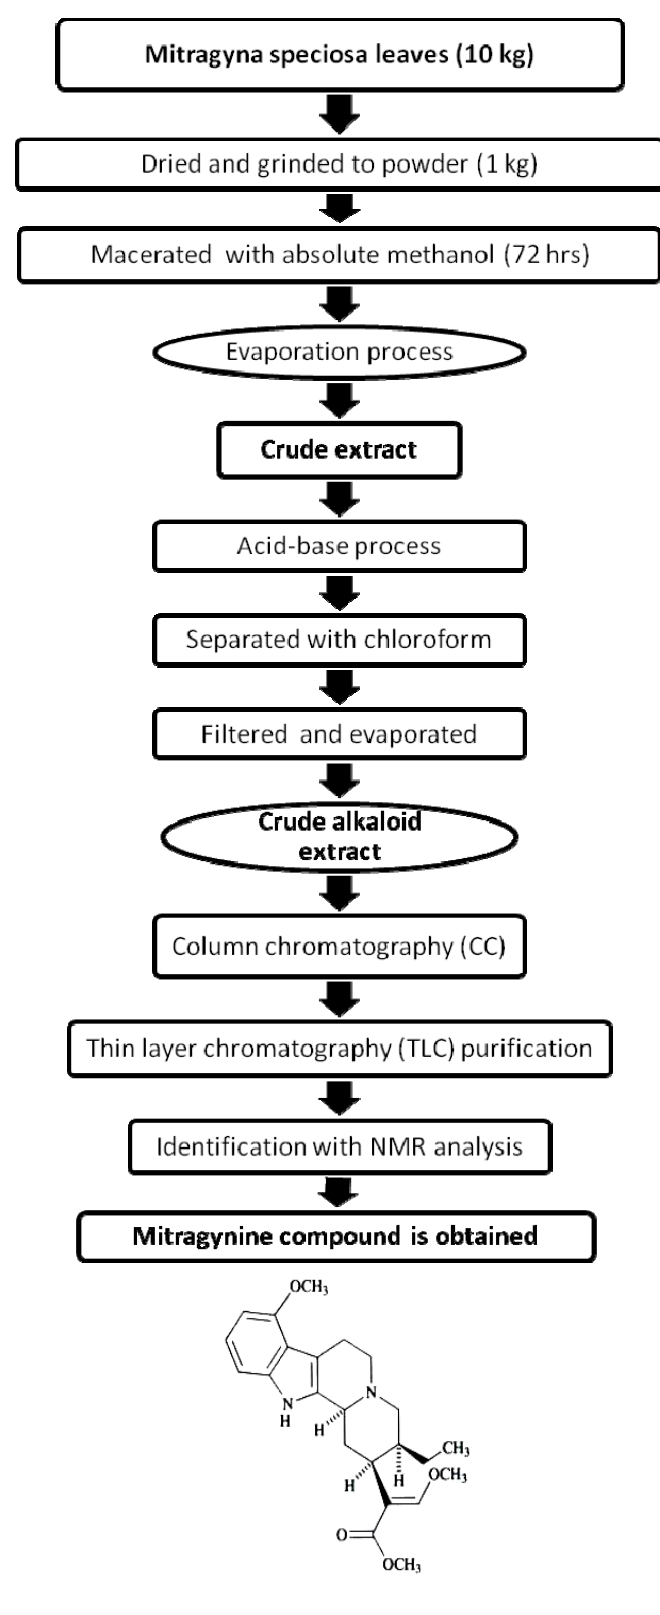
Figure 8. Schematic representation of isolation of mitragynine from Mitragyna